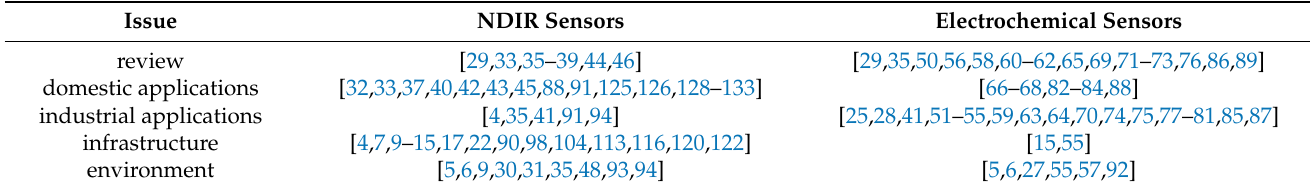
Table 3. References classified according to application and sensor